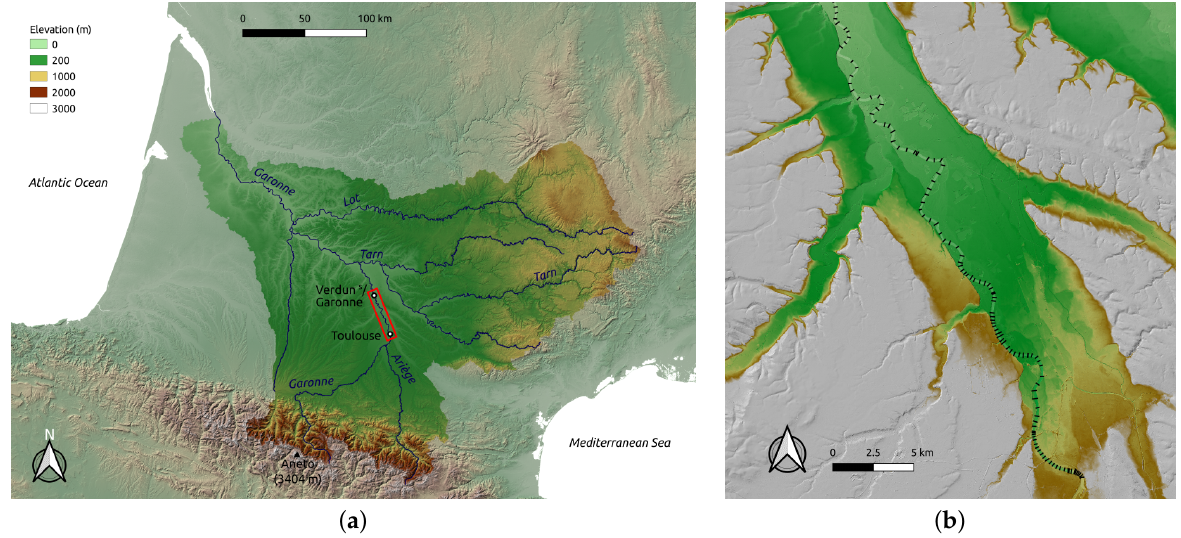
Figure 7. Location of the reach of the Garonne river investigated in this study. ( a ) Location of the reach in the whole Garonne catchment, between Toulouse and Verdun-sur-Garonne; ( b ) in situ cross-section data used for